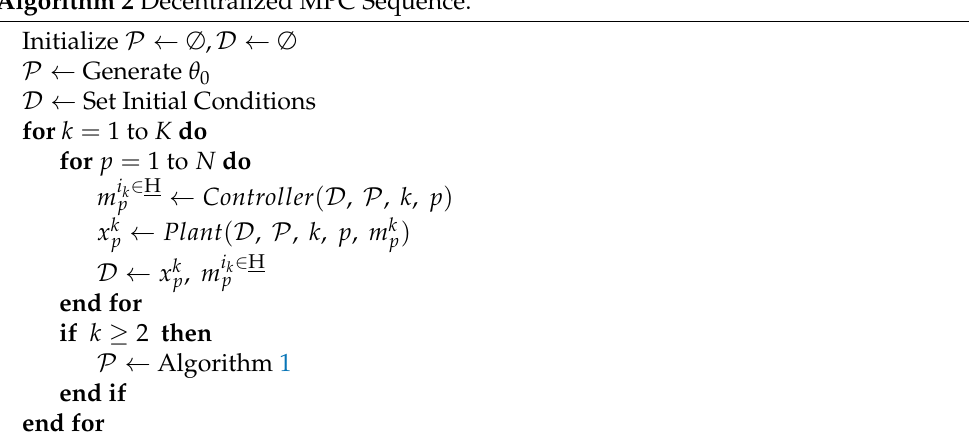
Algorithm 2 Decentralized MPC